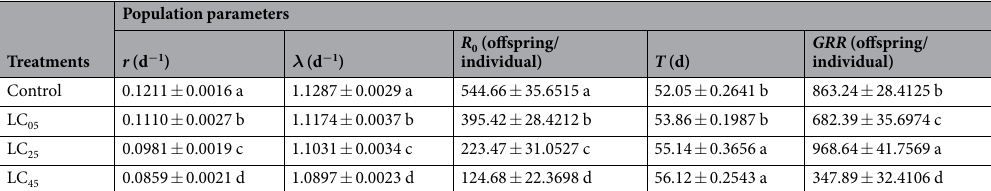
Table 3. Estimates of life table parameters of A. ipsilon when 3rd-instar larvae were exposed to low-lethal concentrations of chlorantraniliprole. SEs were estimated using 200,000 bootstraps and compared with paired bootstrap tests based on the 5% significance level. Means followed by different lowercase letters in the same column are significantly different ( P < 0.05). r = the int r insic rate of increase; λ = the finite rate of increase; R 0 = the net reproduction rate; T = the mean generation time; GRR = the gross reproduction